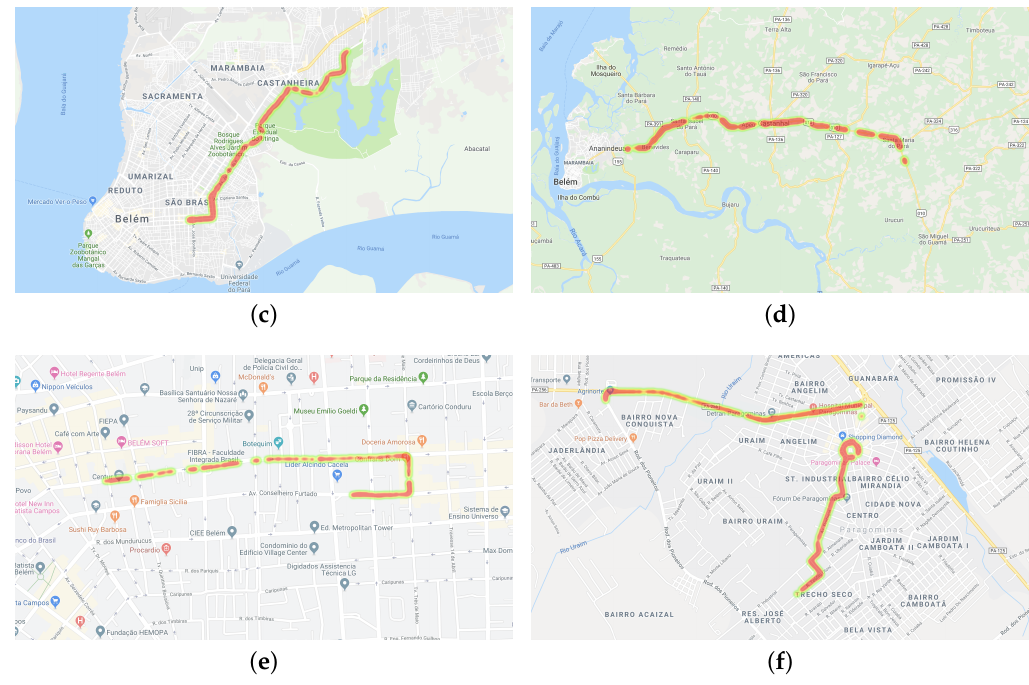
Figure 3. Trips made by volunteers to collect sensor data. Figures ( a – c ) were trips performed by drivers and Figures ( d – f ) were trips conducted by